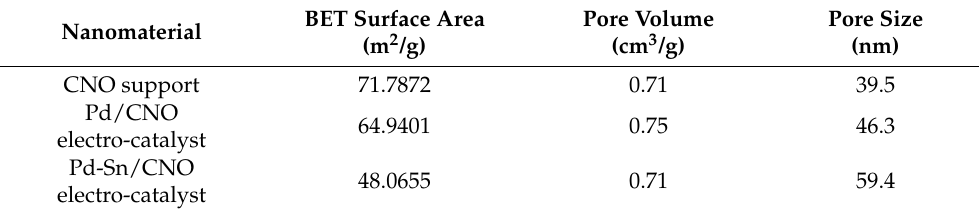
Table 6. Summary of BET data for CNOs, Pd/CNOs, and